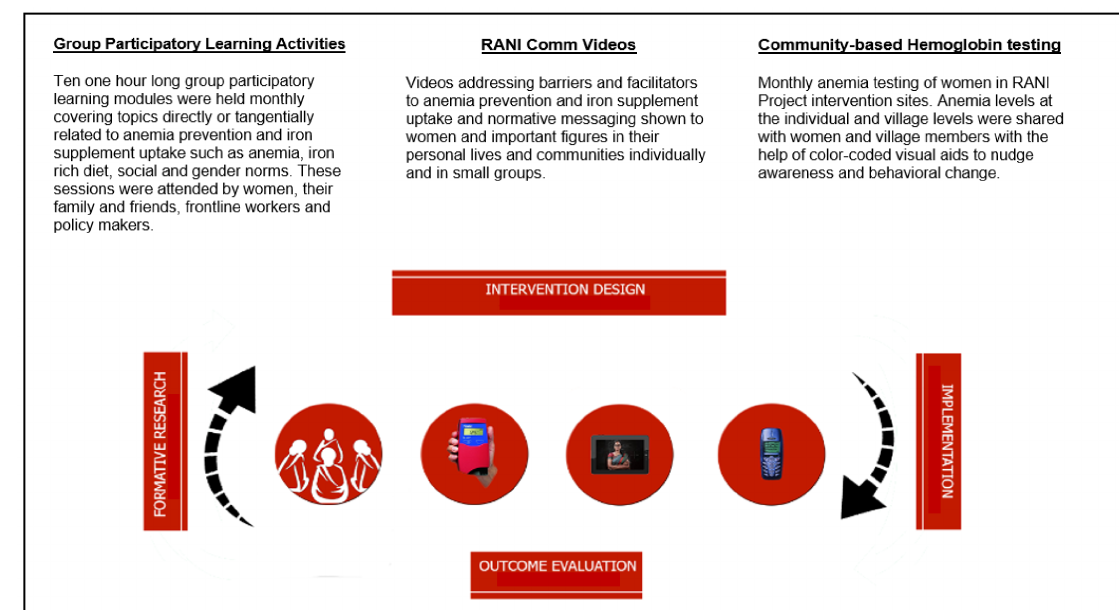
Figure 1. Visualization and description of RANI Project intervention